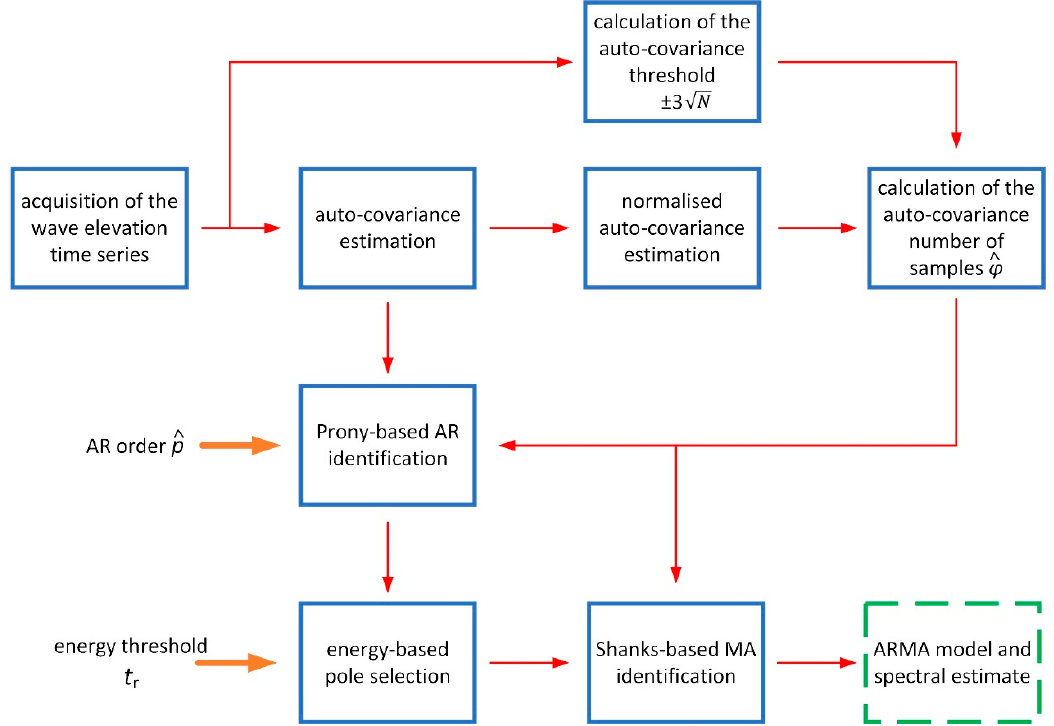
Figure 14. Workflow of the ARMA model estimation procedure. Thick orange arrows indicate user inputs, blue boxes the various steps of the procedure, thin red arrows their outputs and the green dashed box the final estimation result.